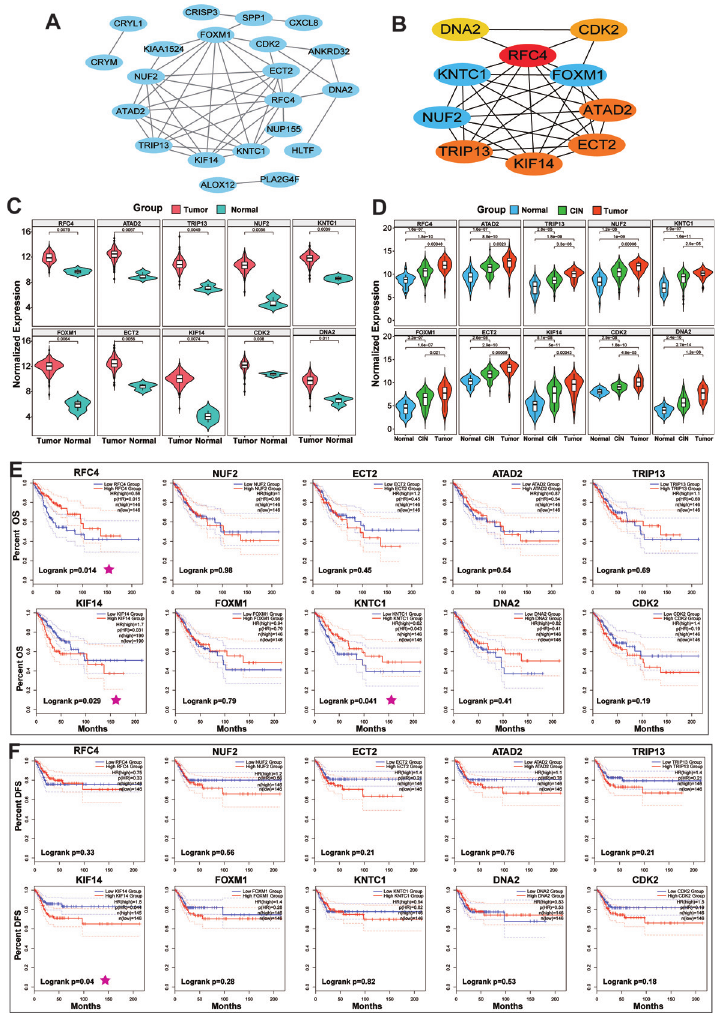
Figure 5. Identi fi cation of hub genes. A , Protein-protein interaction network analysis was performed. Twenty-one nodes and 45 edges were obtained with con fi dence scores X 0.7. B , The top ten genes were selected as candidate hub genes according to the MCC algorithm. C , Violin plots present the expression of the ten hub genes in cervical cancer (CC) tissues compared to the cervical intraepithelial neoplasia (CIN) and cervical normal tissues in the GSE63514 database. D , Violin plots present the expression of the ten hub genes in CC tissues compared to cervical normal tissues in the TCGA database. E , Overall survival (OS) plots in response to the expression of the ten hub genes are shown. F , Disease-free survival (DFS) plots in response to the expression of the ten hub genes are